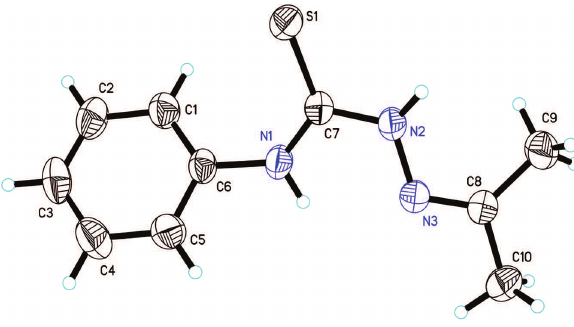
Table 1: Data collection and handling.